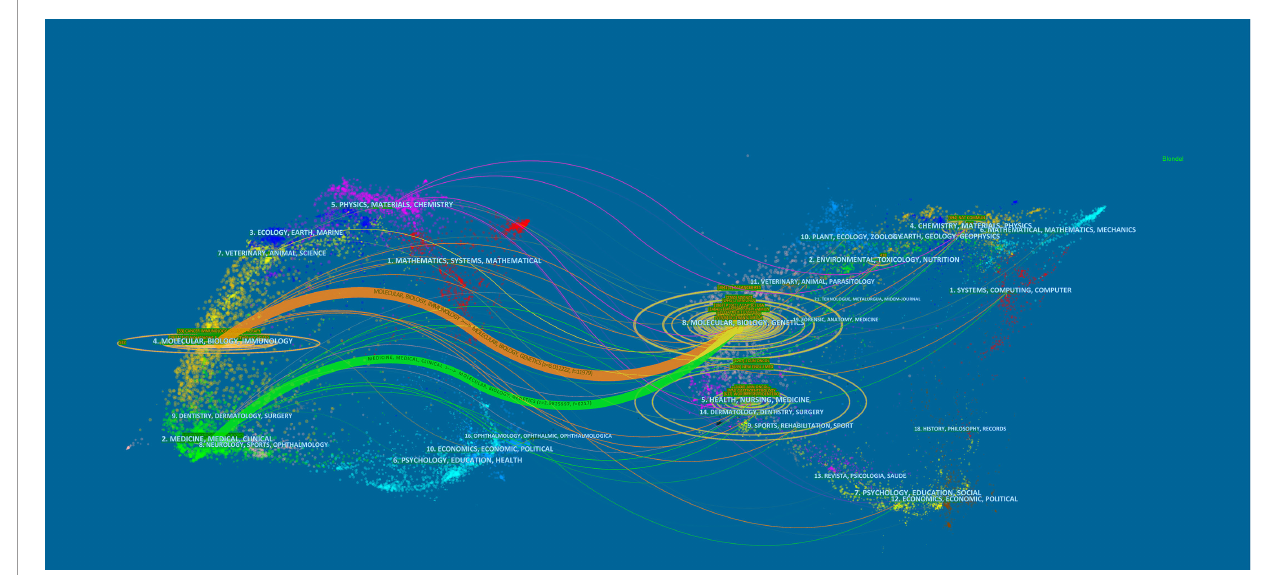
FIGURE 4 | The dual-map overlay of journals related to colorectal cancer immunotherapy. Notes: On the left were the citing journals, on the right were the cited journals, and the colored path represented the citation relationship.